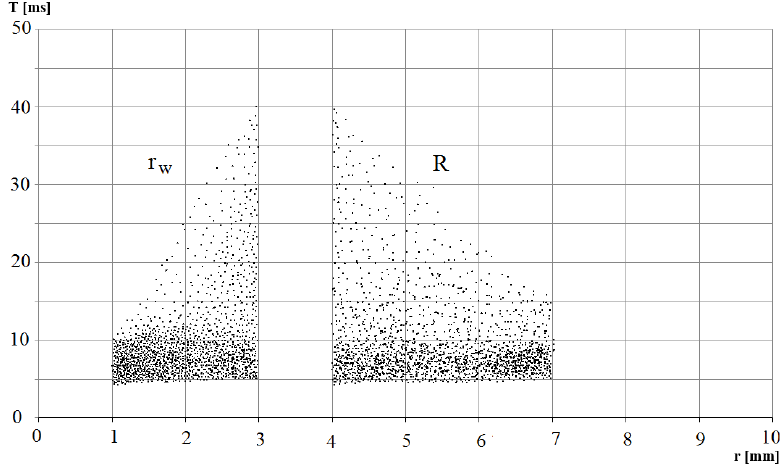
Figure 18. Dependence of the time T on the radius r w and on the radius R.